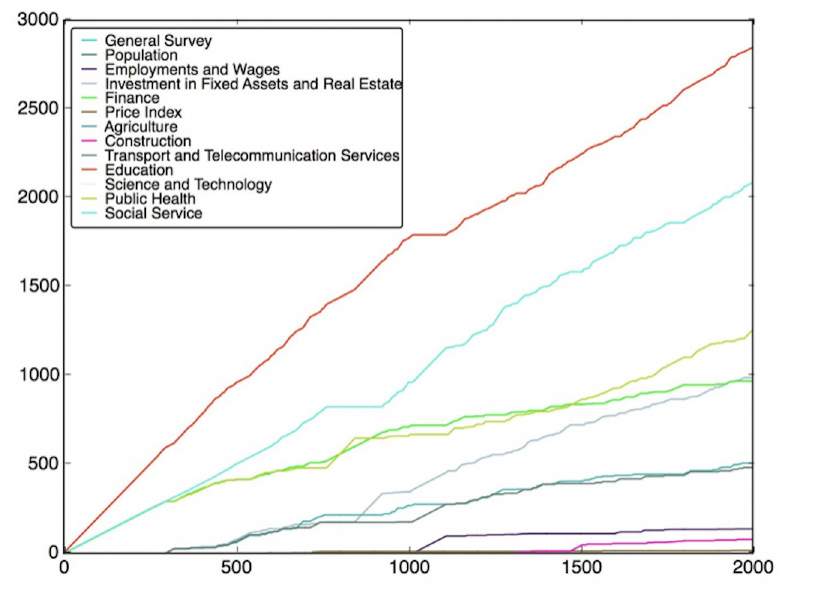
Fig 14. SVR with 5 features and genetic algorithm.